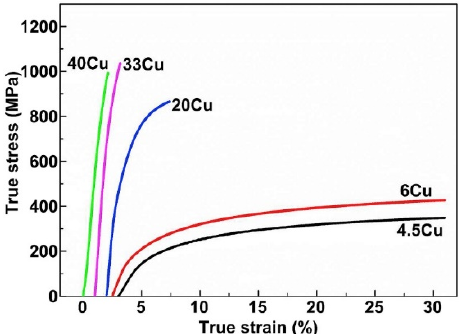
Figure 51. Compressive stress-strain curves of SLM Al-xCu alloys [115]. Copyright 2017. Adapted with permission from Elsevier Science Ltd. under the license number 4803750369772 (Figure 4 [115]),